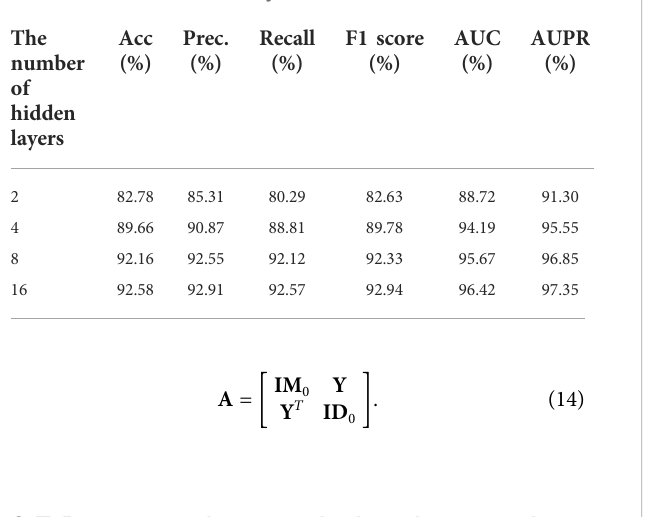
TABLE 4 In fl uence of hidden layers.